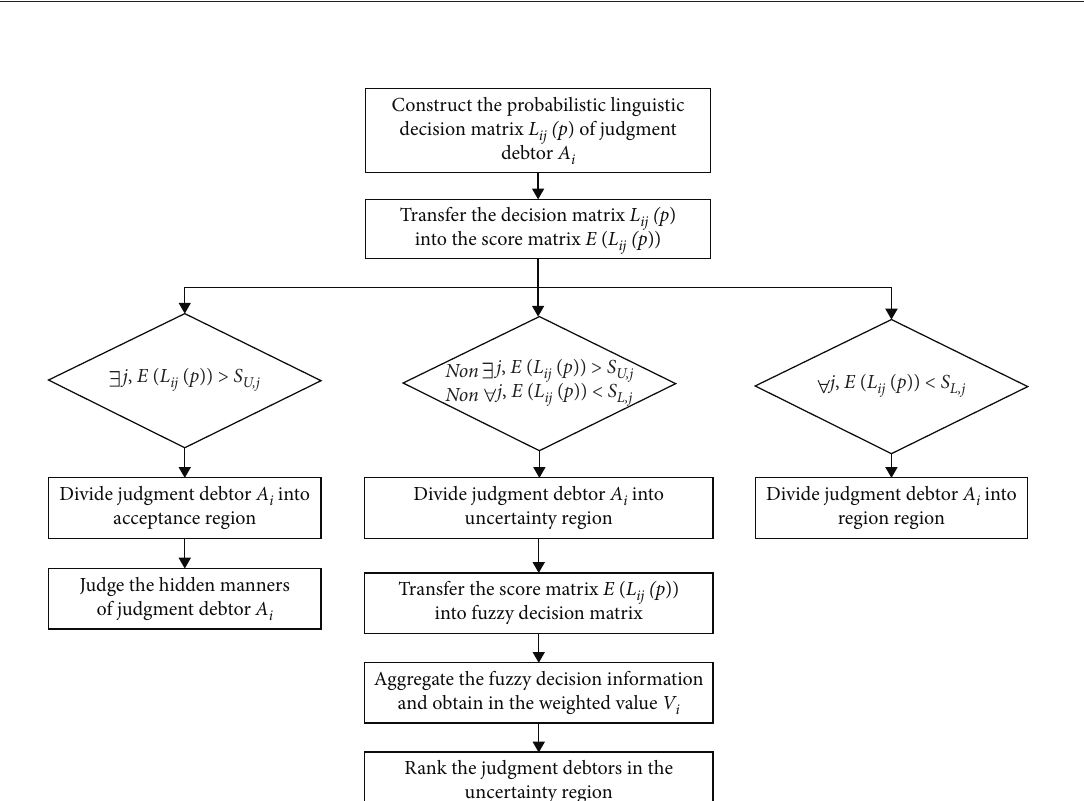
Figure 6: Flowchart of hidden property evaluation of judgment debtors.